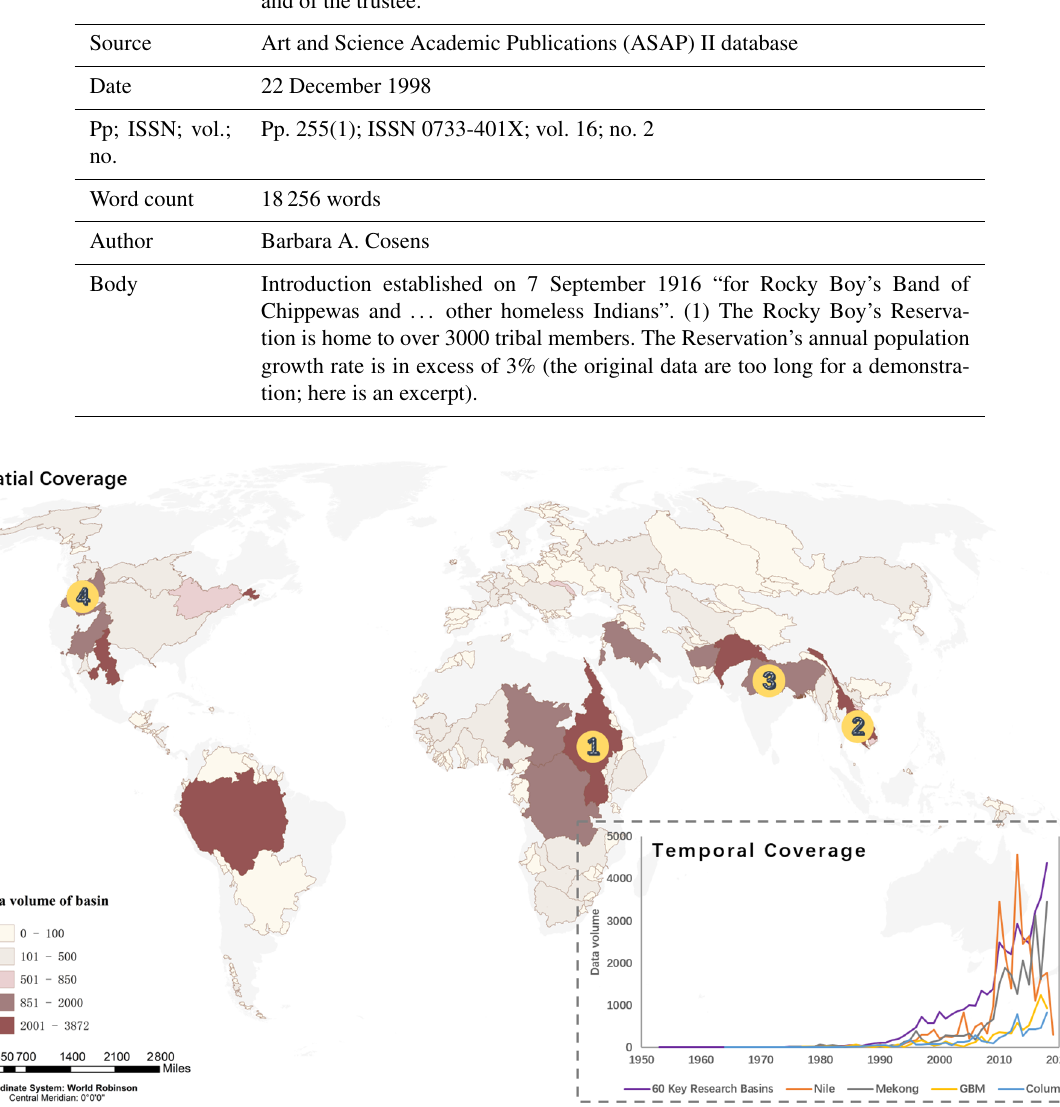
nition criteria of key research basins (more than 100 articles) and heated basins (more than 850 articles) are flexible and adaptive according to specific research